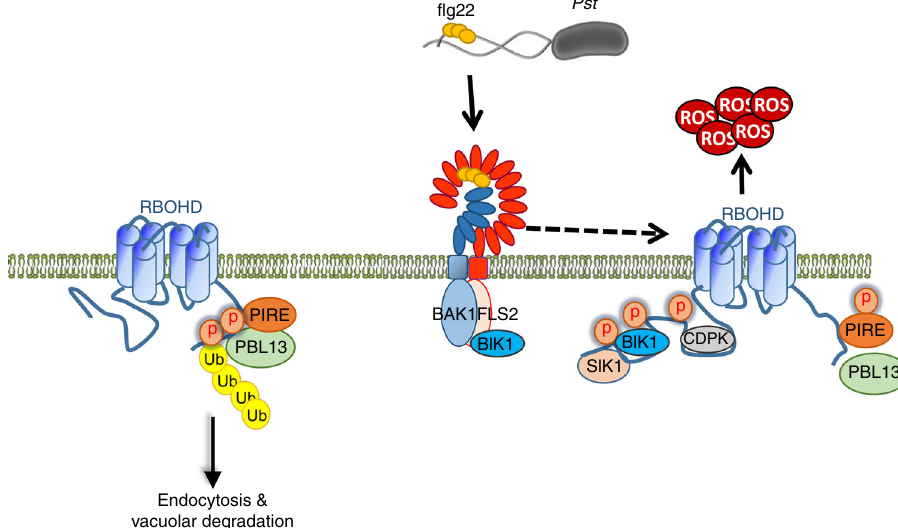
Fig. 8 Model of PBL13 and PIRE regulation of RBOHD. RBOHD ’ s C-terminus is phosphorylated and ubiquitinated by PBL13 and PIRE, respectively, at a resting state, which leads to reduced RBOHD stability through vacuolar degradation. Upon fl g22 perception, RBOHD is activated by N-terminal phosphorylation, resulting in an apoplastic ROS burst and ROS-mediated immune responses. PIRE is dynamically phosphorylated during immune FLAG-RBOHD T912A , and FLAG-RBOHD T912D . After 18 h, total protein was extracted and RBOHD expression was determined by immunoblot with anti- FLAG-HRP at a concentration of 1:5000 (Sigma, SAB4200119, clone 6F7). Co-immunoprecipitation . For co-immunoprecipitation in N. benthamiana , pENTR- LTI6b-3xFLAG and pENTR -RBOHD were recombined into pEarlygate104